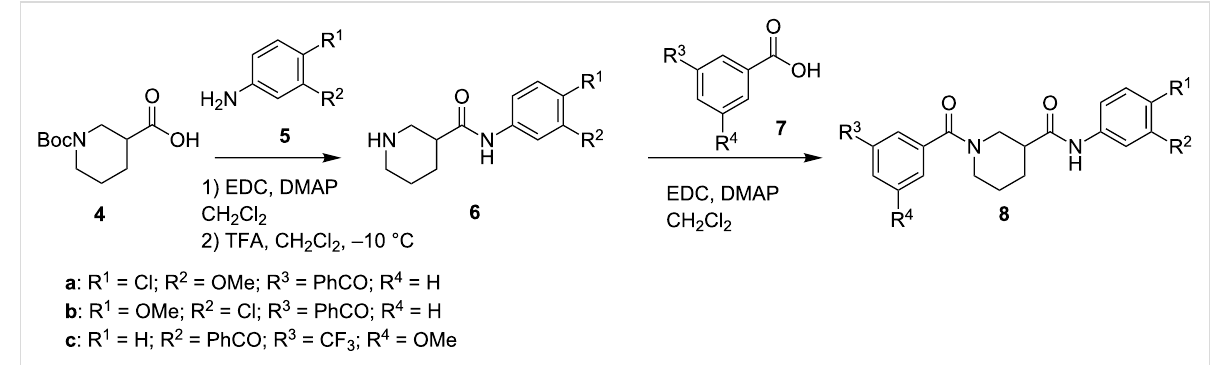
Scheme 1: General synthesis of model benzophenone probes.